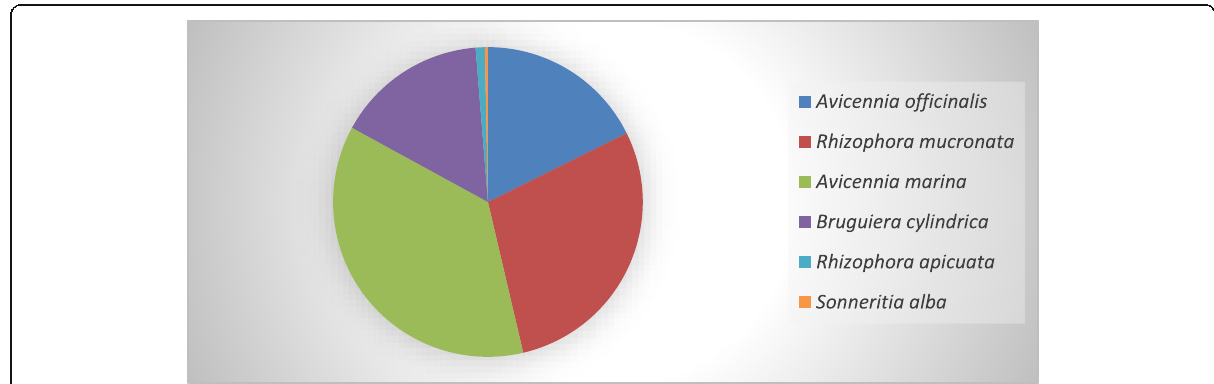
Fig. 2 Mangrove species density in the study